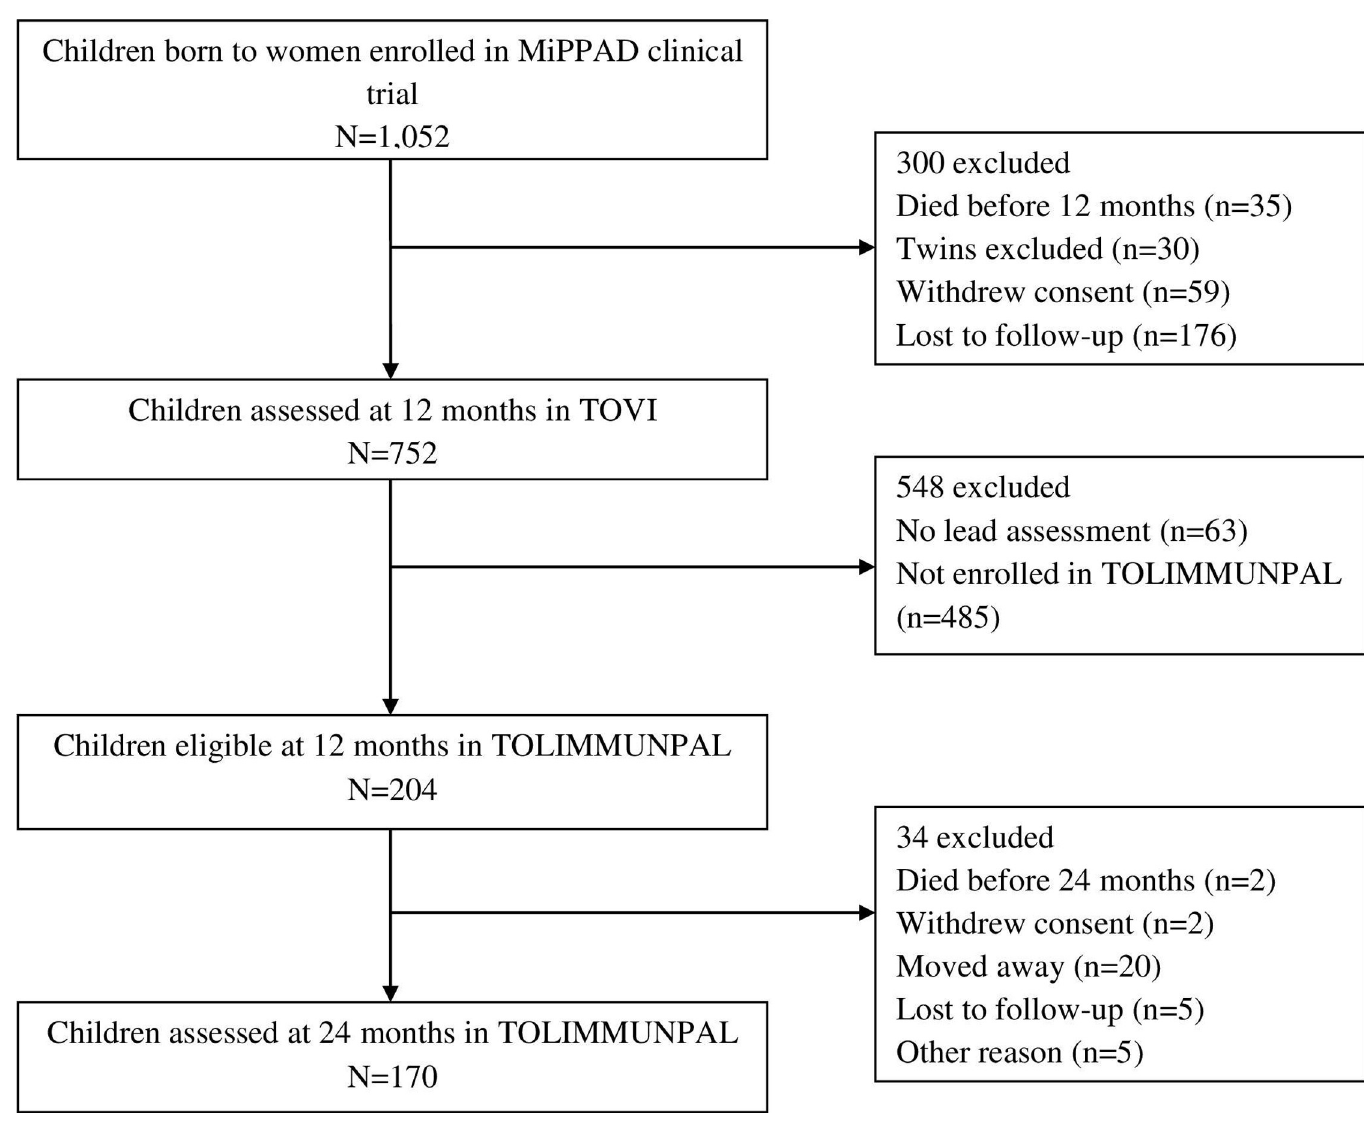
Fig 1. Population follow-up. Follow-up of participating children from birth to 24 months of